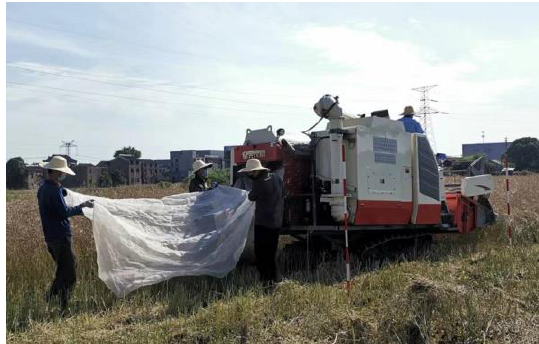
Figure 12. Pavement test results of tracking effect.